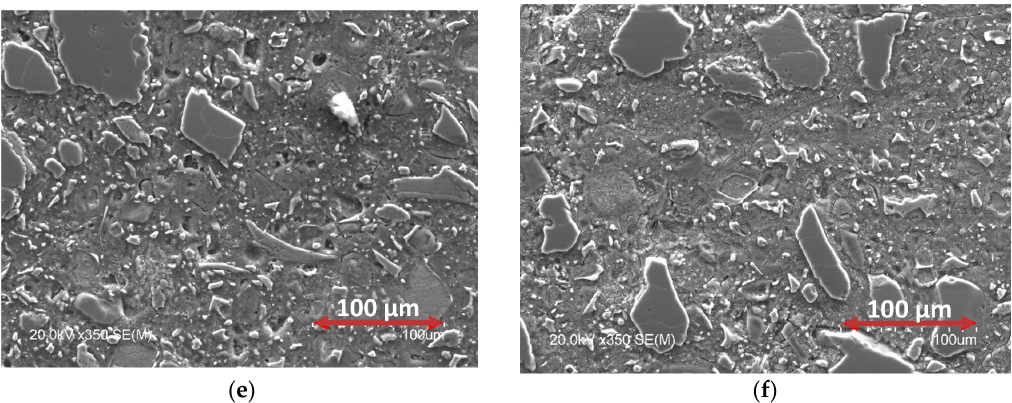
Figure 10. Backscattered SEM image of mortars made with the high-reactive siliceous pebble, ASJ_12 after 90 days of testing and subsequent preservation in a 1N NaOH solution for 30 months: ( a ) reference mortar; ( b ) reference mortar; ( c ) mortar with 10% of natural pozzolan; ( d ) mortar with 10% of siliceous coal fly ash; ( e ) mortar with 10% of silica fume; ( f ) mortar with 10% of blast-furnace slag.